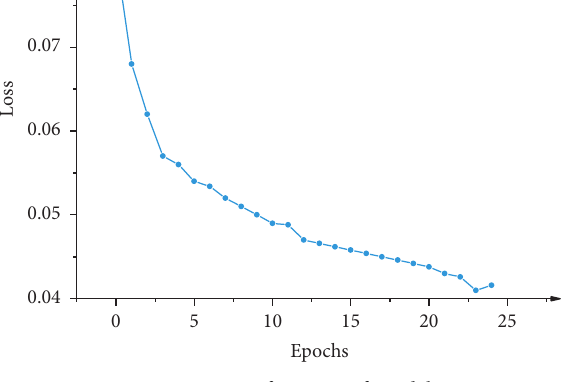
Figure 8: Loss function of model. Table 5: Distributions of category predictions.